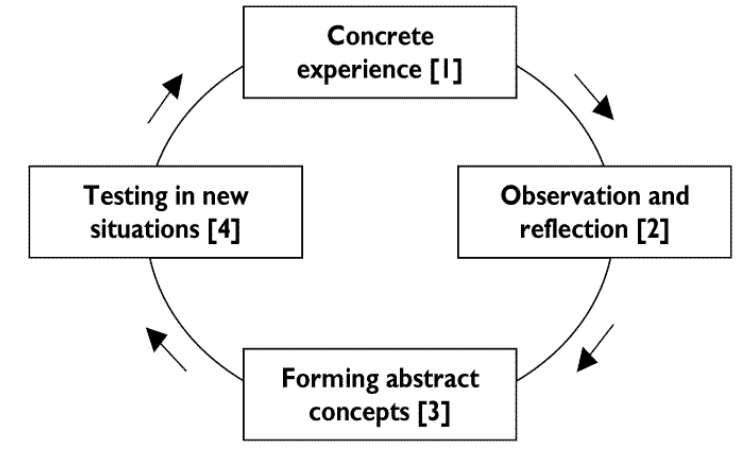
Fig. 1. Experiential Learning